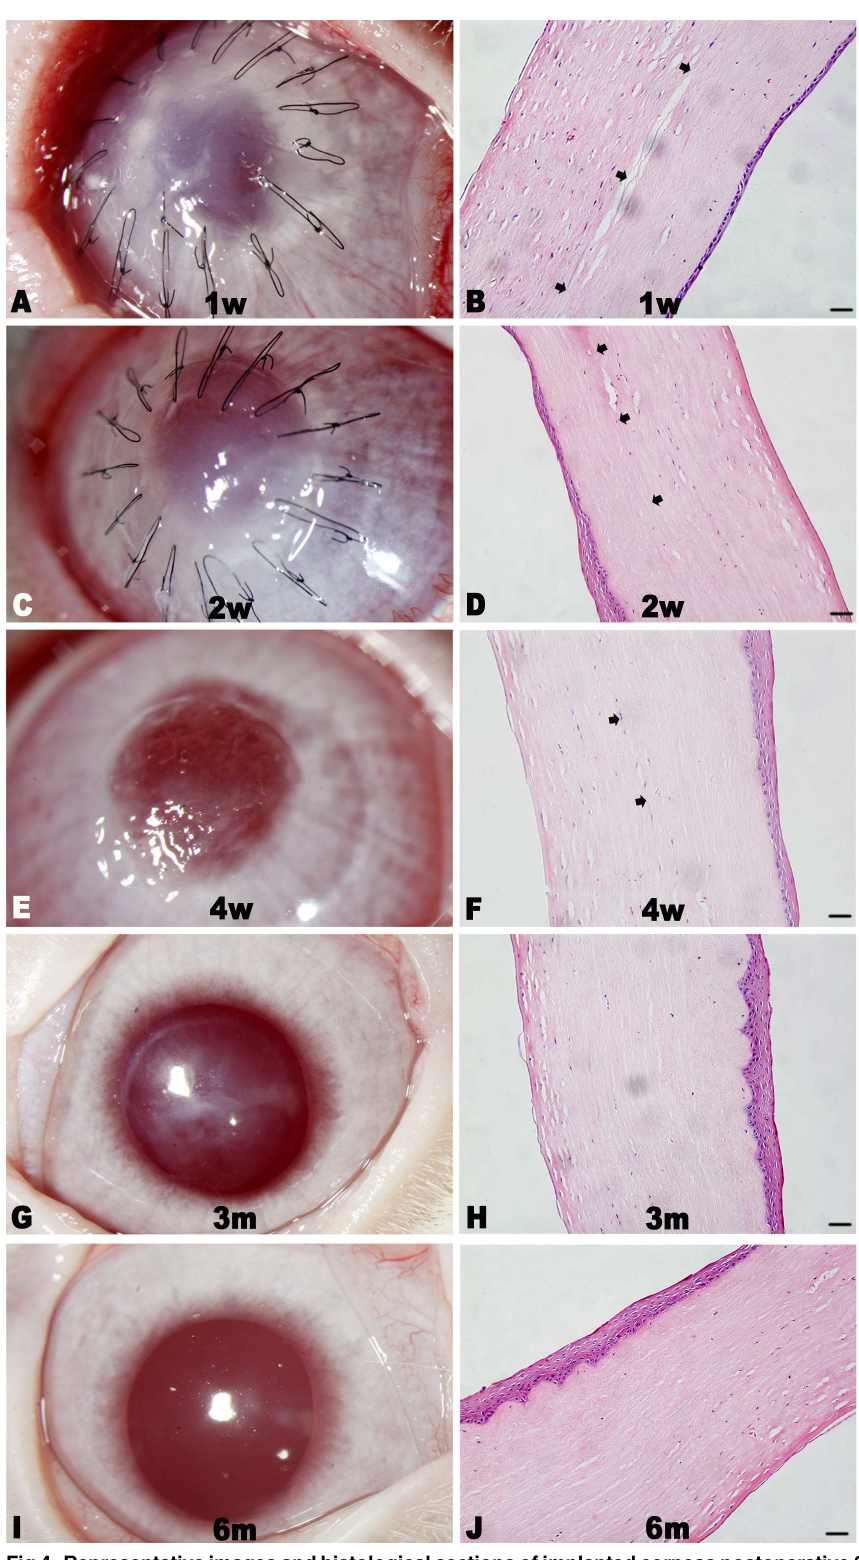
Fig 4. Representative images and histological sections of implanted corneas postoperative 6 months. The implantedcorneasgraduallycleared with no apparentneovascularization(A, C, E, G, and